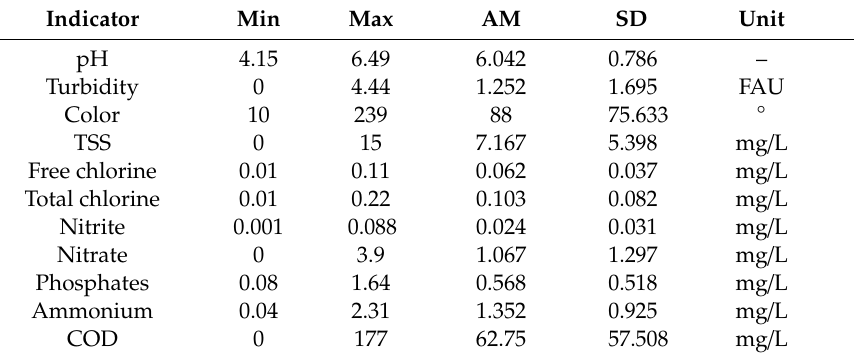
Table 4. General physicochemical results from the Al–Gr treatment approach (number of samples = 12).